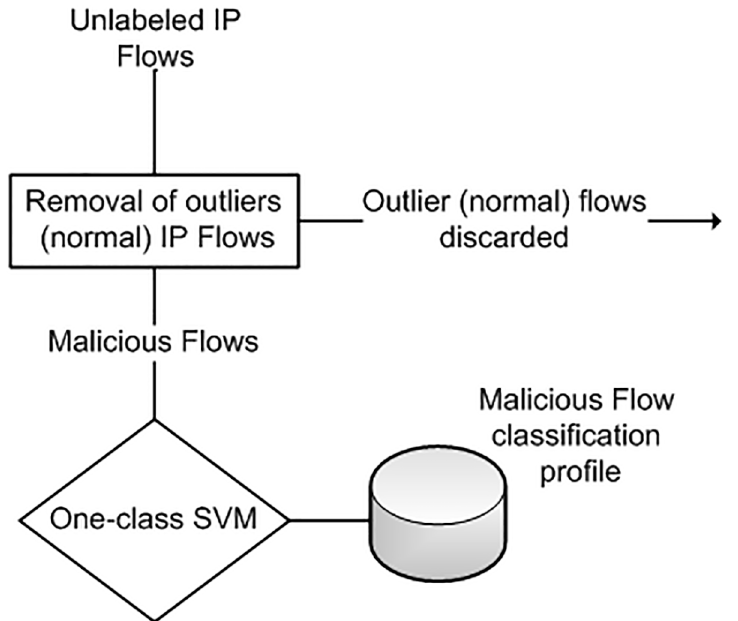
Fig 5. Training of one-class SVM using malicious